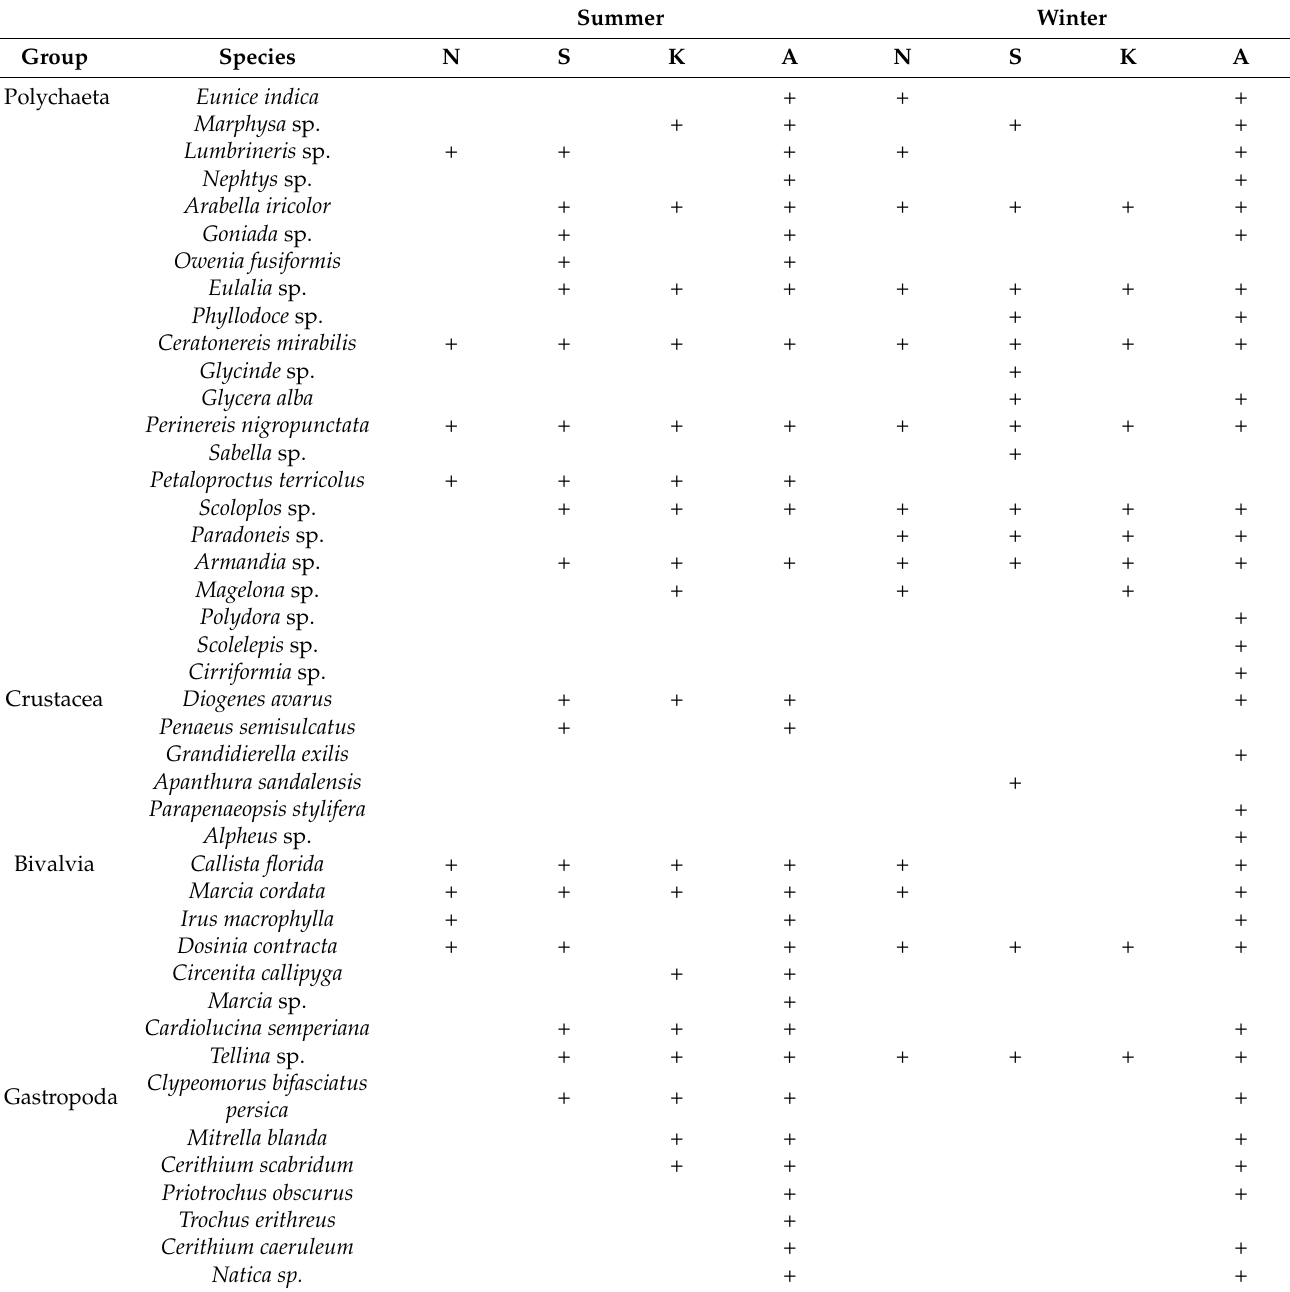
Table 3. List of macrofaunal species recorded in the four study areas during the summer and winter seasons (+ indicates the presence of species).